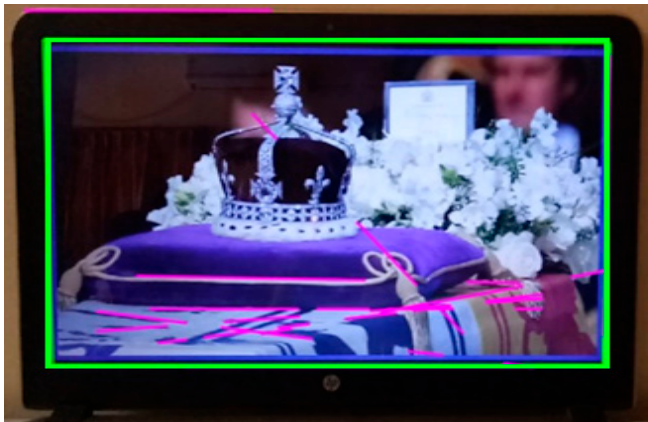
Figure 13. ( a ) Reference Image, ( b ) Captured Image, ( c ) Matched Features, ( d ) Valid Features, ( e ) Restored Image.